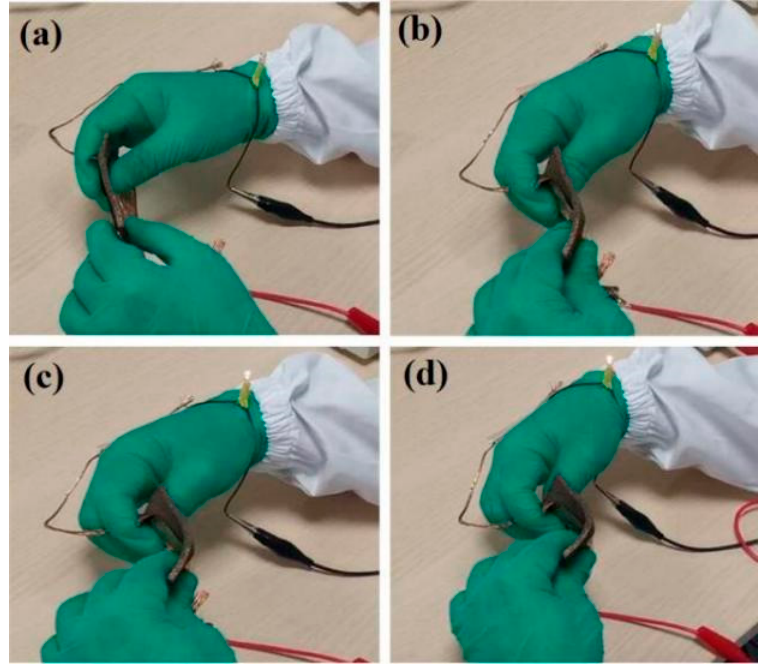
Figure 12. Flexible switch applications: ( a ) 180°, ( b ) 150°, ( c ) 120°, and ( d ) 90°.